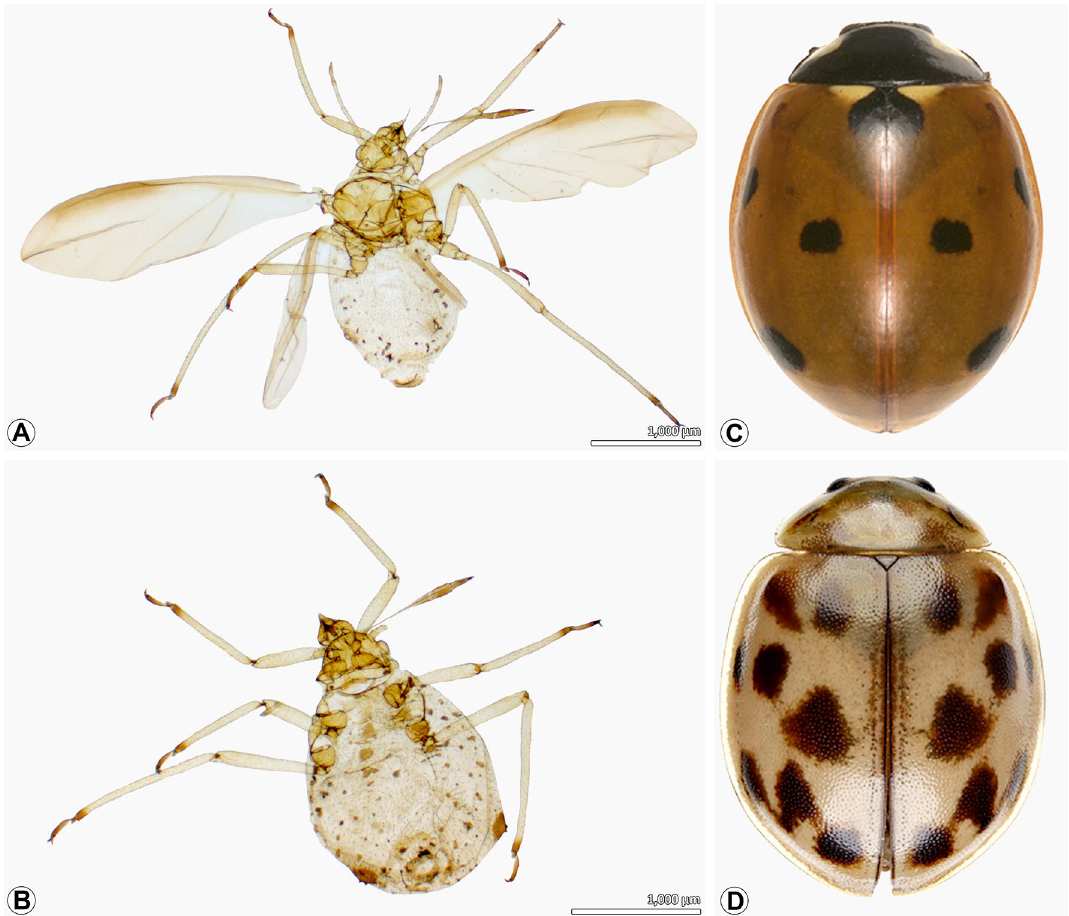
Figure 4. Dominant species associated with the Chinese thuja trees, Platycladus orientalis (L.) in three urban green spaces in Mashhad, Iran. ( A ) Cinara tujafilina Del Guercio, 1909, adult alate. ( B ) Cinara tujafilina Del Guercio, 1909, adult apterous. ( C ) Coccinella septempunctata Linnaeus, 1758. ( D ) Oenopia conglobata Linnaeus,